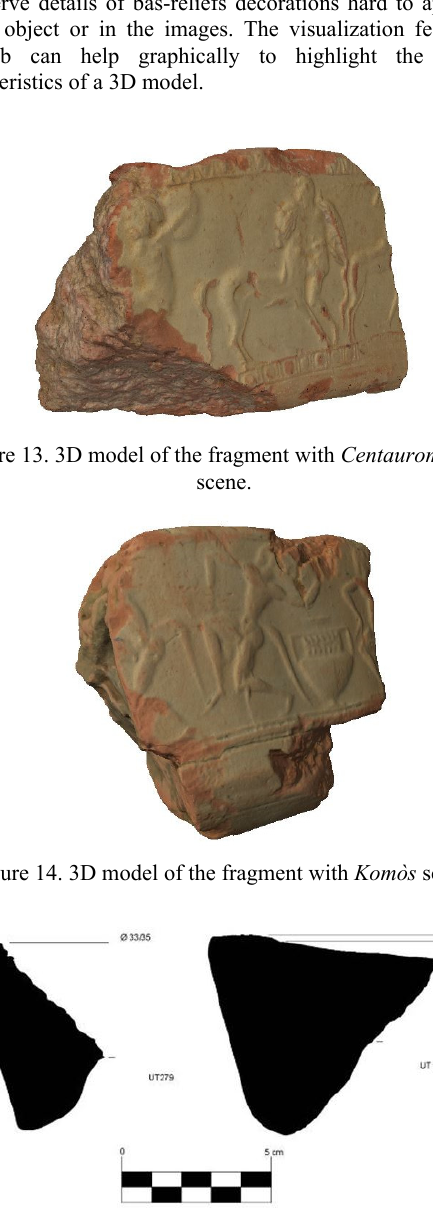
Figure 15. Manual orientation of the fragments with Centauromachia (on left) and Komòs (on right) scene.